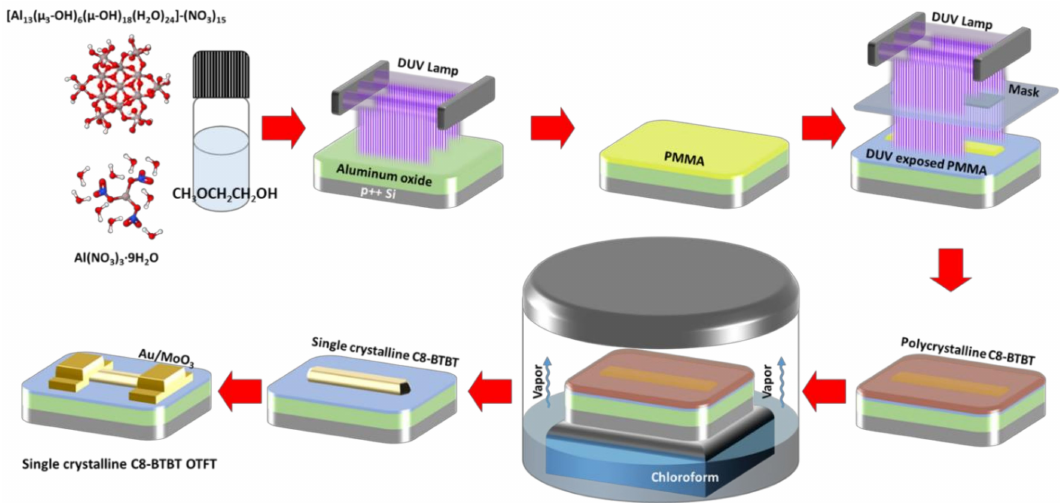
Figure 1. Schematic illustration of the fabrication of single-crystal C8-BTBT organic thin-film transistors (OTFTs) based on solution-processed Al 2 O 3 gate dielectric films.